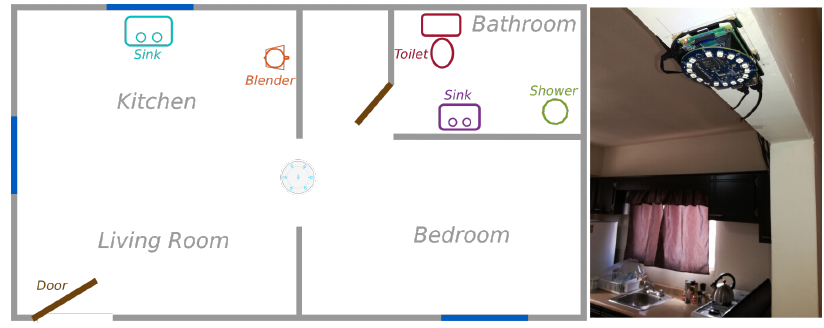
Figure 7. Setup used to record audio samples of home activities in the